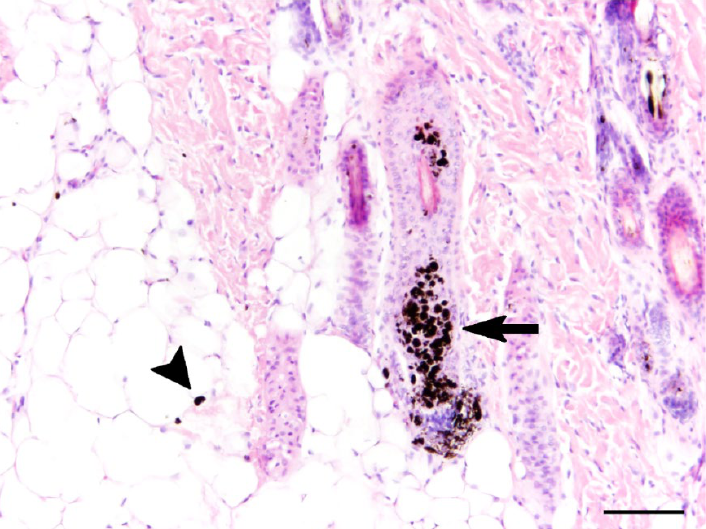
Figure 2. Histopathology of the skin. Multifocally, epithelial cells of hair follicles displayed an accumulation of clumped melanin (arrow) and deposition of accumulated keratin. In the dermis, a mild, multifocal pigmentary incontinence (arrowhead) was present. Hematoxylin and eosin stain (bar = 100 µm).